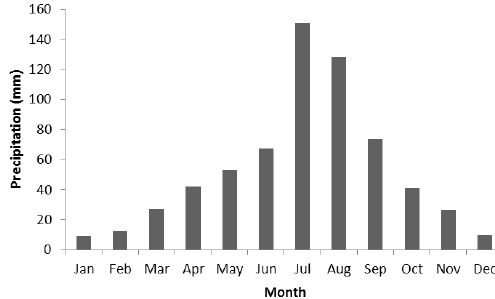
Fig. 2. Monthly precipitation in Zhengzhou.